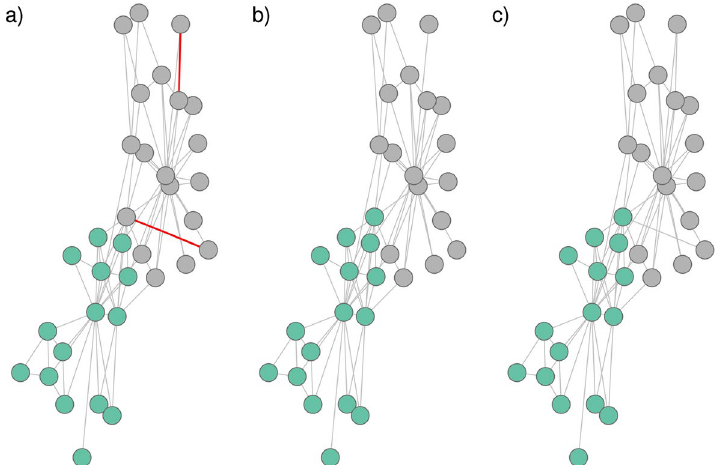
Fig. 5 The network of Zachary karate Club (Experiment 2). a The communities inferred by ACD. The edges inferred by our algorithm as the anomalous edges are shown in red. Here, π = 10 − 4 , µ = 0.1 . b The communities inferred by CD (i.e. ACD with π = µ = 0 ). c Ground truth